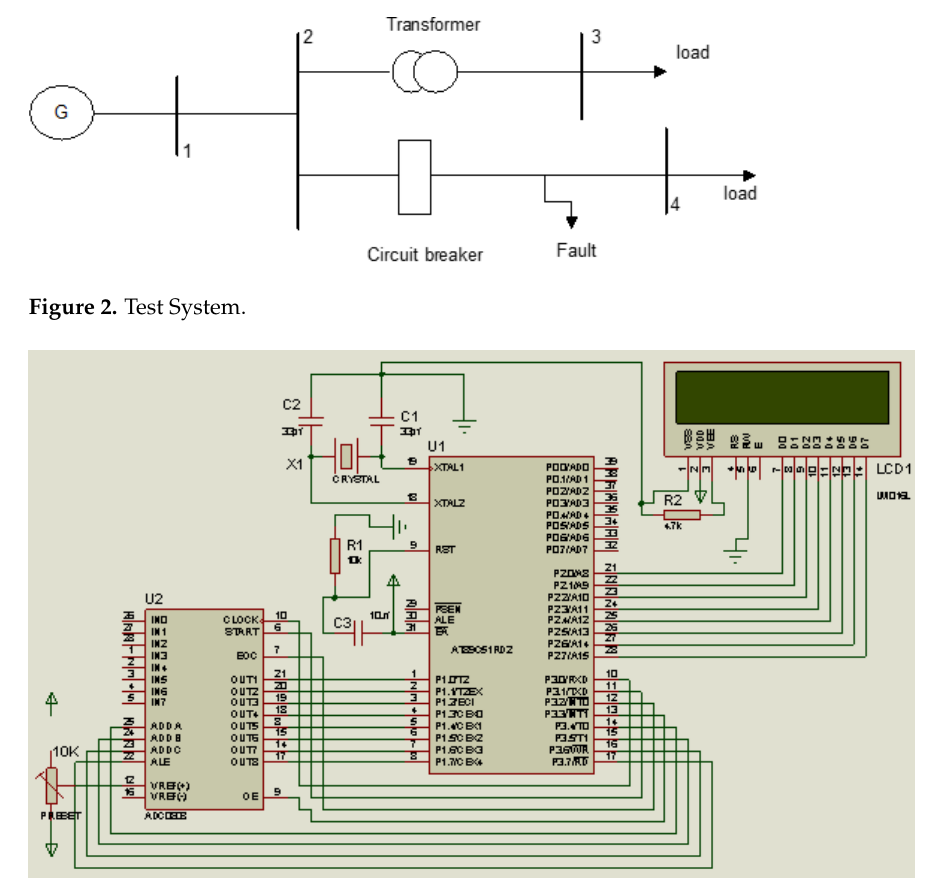
Figure 3. Laboratory Testing